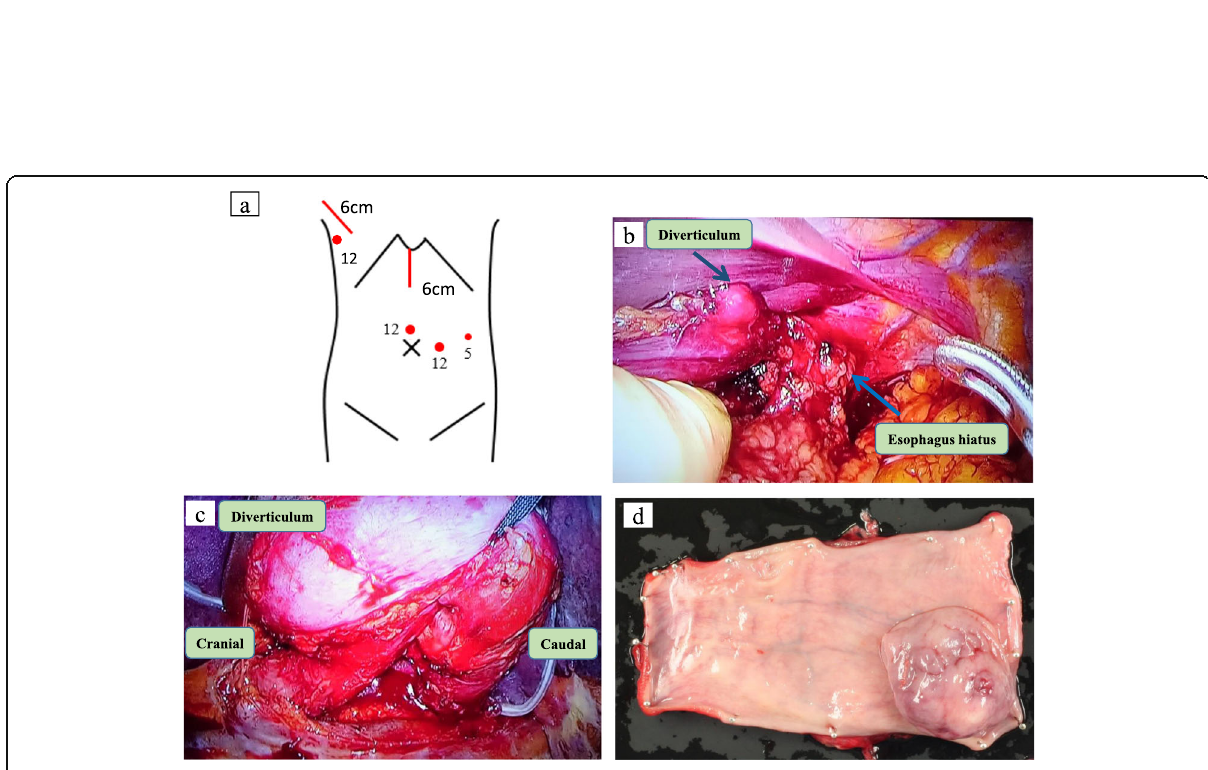
Fig. 3 Operative findings and resected specimen. a The skin incision and the trocar placement (two 12-mm trocars and one 5-mm trocar in the abdomen and one 12-mm trocar in the chest). b Peeling of the hiatus. c Taping the huge right-sided diverticulum. d Resected specimen showing no abnormalities on its mucosal